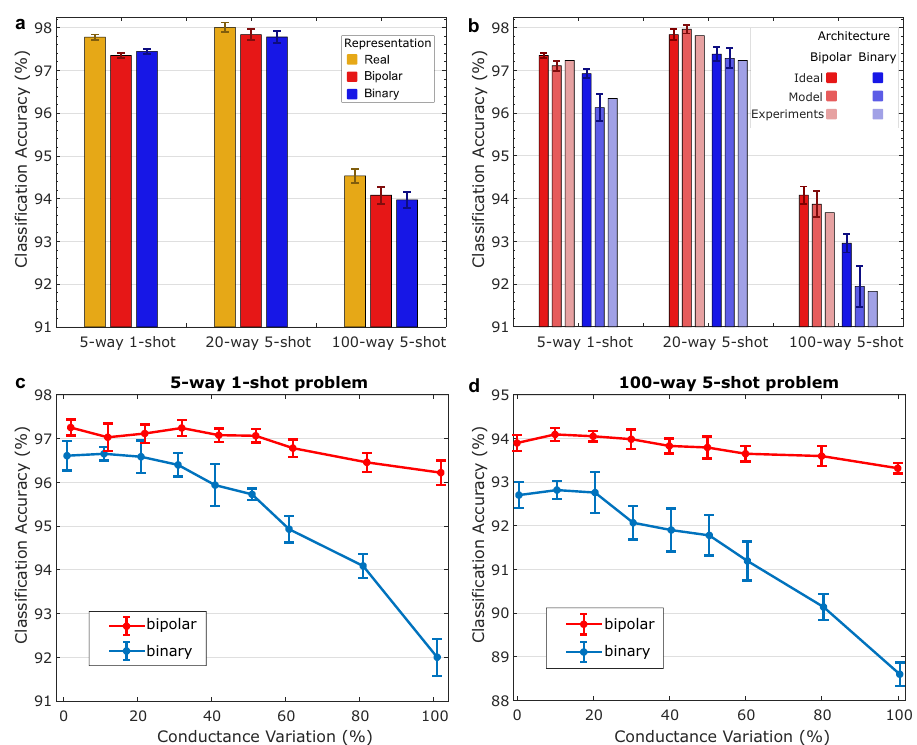
Fig. 5 Experiments on Omniglot classi fi cation. a Average software classi fi cation accuracy with the real, bipolar, and binary vector representations on three problems, each using the approximate sharpening function (i.e., the regular absolute), and the precise similarity function (i.e., the cosine) over 10 test runs each containing 1000 few-shot episodes (effectively 10,000 episodes); these capture the net effect of changing vector representations in software. b Classi fi cation accuracy results with the hardware-friendly inference architecture on an ideal crossbar without any PCM variations, a crossbar simulated with the PCM model (see Methods), and the actual experiments with the PCM devices (see Methods). The ideal and the PCM model simulations are conducted over 10 test runs each containing 1000 few shot episodes (effectively 10,000 episodes). The experiments were conducted over one test run containing 1000 episodes. c Classi fi cation accuracy as a function of percentage of device conductance variation in the PCM model with bipolar and binary as architectures for the 5-way 1-shot problem, and the ( d ) 100-way 5-shot problem. The error bars represent one standard deviation of sample distribution on either directions in all